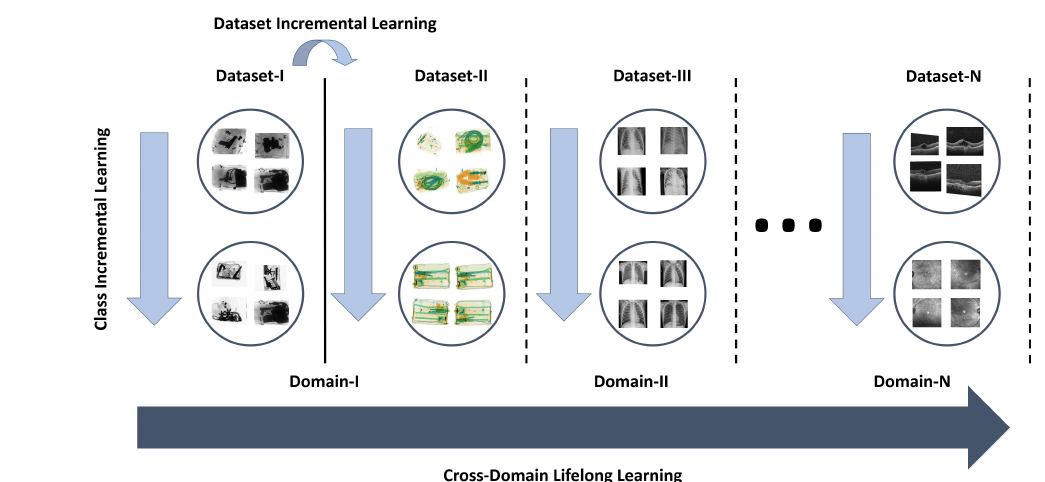
Figure 2. Block diagram of the proposed framework. The proposed framework can mainly be split into two phases where, in the first phase, it performs class incremental learning for a specific problem/dataset, while in the second phase, it learns about new tasks from a multimodal dataset spanning different applications without forgetting the prior